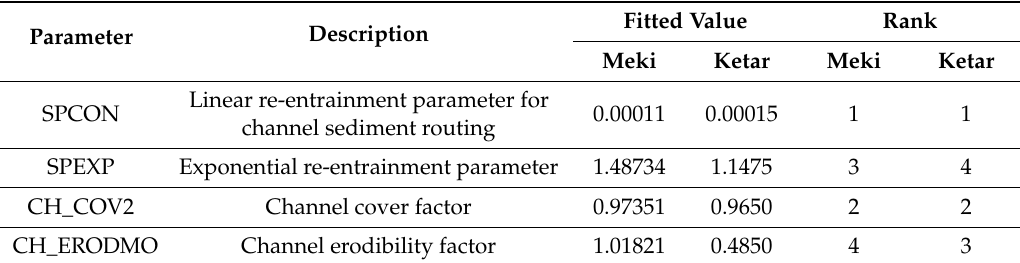
Table 3. Parameters for sediment calibration and their ranks.